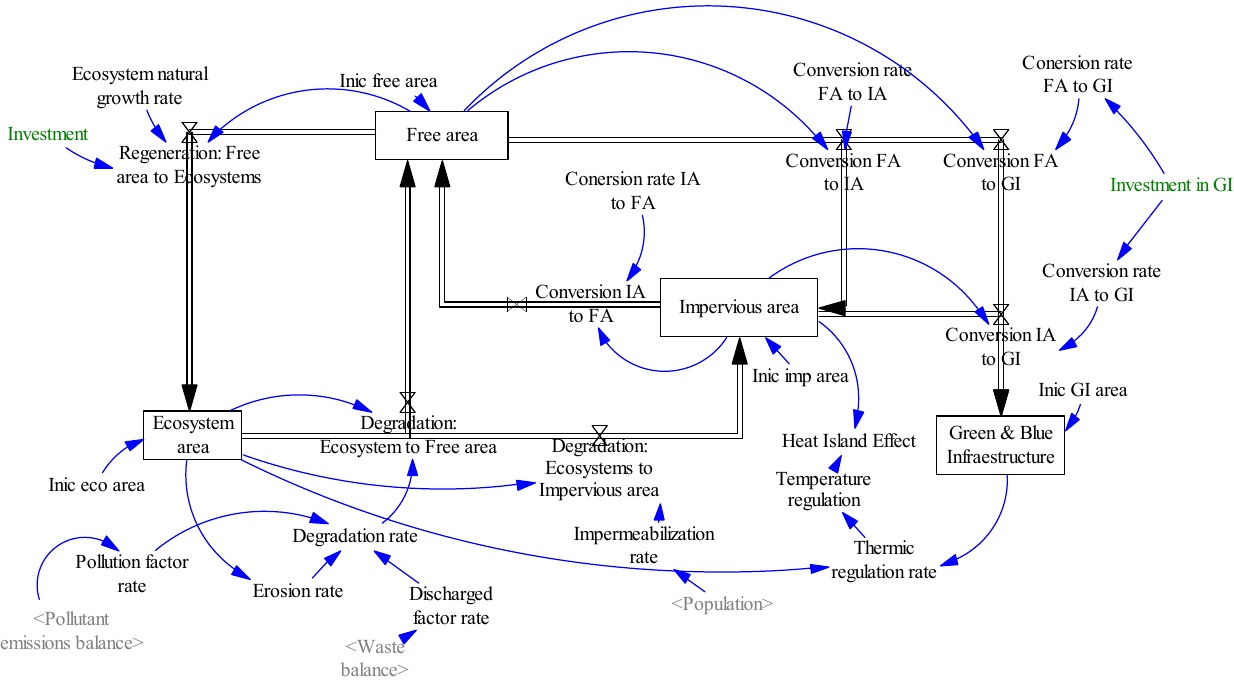
Figure 6. Areas distribution system (own elaboration).